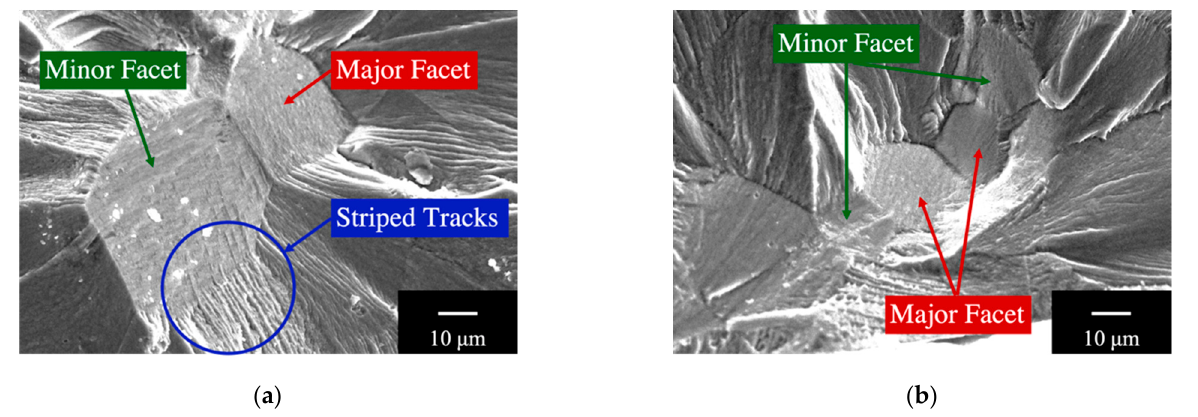
Figure 7. SEM images of the multiple facets under negative stress ratios. ( a ) σ max = 800 MPa, R = − 0.5, N f = 4.7 × 10 6 ; ( b ) σ max = 625 MPa, R = − 1, N f = 2.0 × 10 7 . Table 3. Characteristics of the major and minor facet.